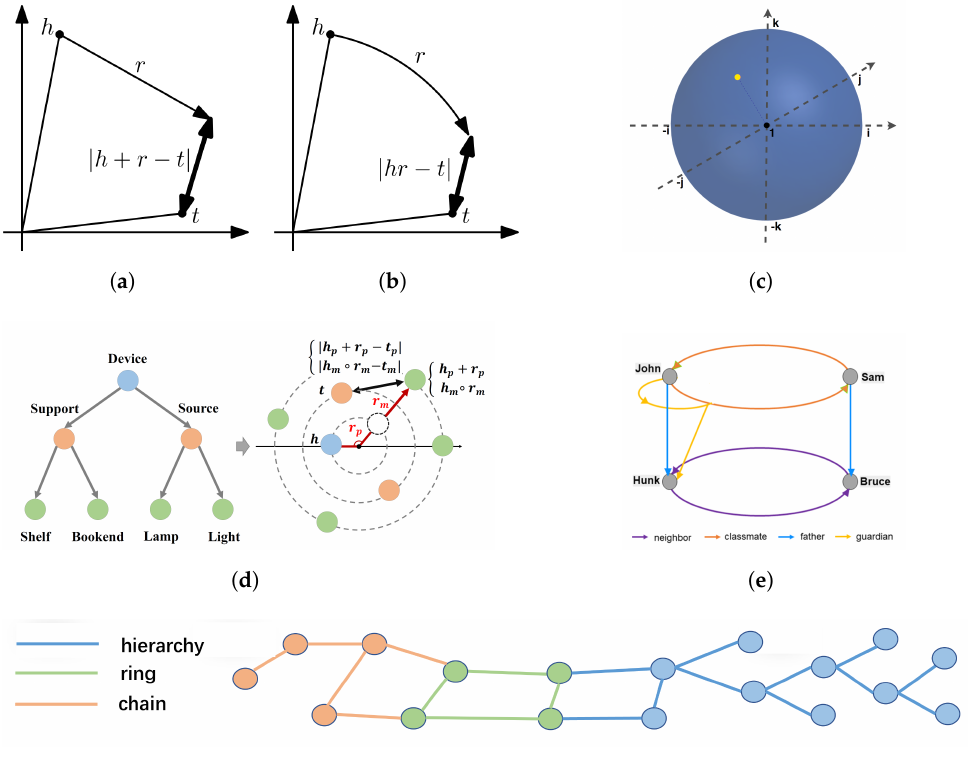
Figure 4. Illustration of transaction-based models. ( a ) TransE models relation r as a translation vector. ( b ) RotatE models r as a rotation in complex plane. Taken from [28]. ( c ) QuatE: the yellow point indicates the position of the unit quaternion. Taken from [30]. ( d ) Illustration of HAKE taken from [29]. The radial coordinate aims to model entities at different levels of the hierarchy (represented by distinct colors), and the angular coordinate aims to distinguish entities at the same level of the hierarchy. ( e ) The combination of translation and rotation in DualE. Taken from [31]. ( f ) Chain, hierarchy, and ring spatial structures of GIE. Orange entities of the KG show the chain structure, which is modeled in Euclidean space; green entities of the KG present a ring structure, which is depicted in the hypersphere space; blue entities of the KG exhibit hierarchical structures. Taken from [32].